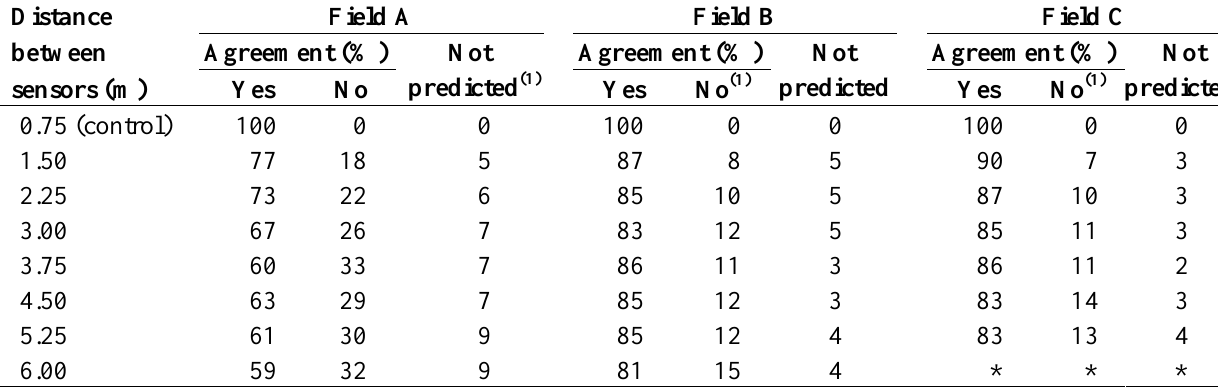
Table 2. Contingency table showing the frequency of points with similar information on weed presence/absence (% agreement) when comparing the reference maps constructed with optical sensors separated 0.75 m and the interpolated maps constructed with progressive increase of spacing between optical sensors. Asterisk (*) indicates that no spatial autocorrelation was